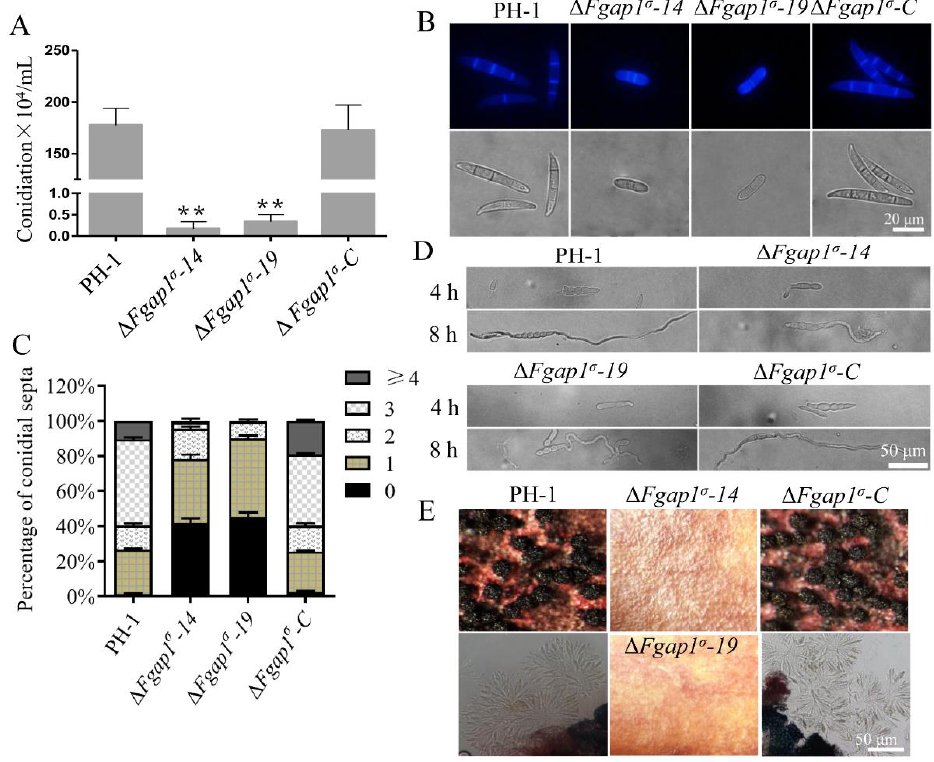
Figure 3. FgAP1 σ is involved in the conidiation and sexual development of F. graminearum . ( A ) Conidiation of the wild-type PH- 1, ΔFgap1 σ , and ΔFgap1 σ -C strains in liquid CMC media for 3 days. Level of significance was measured using an unpaired t -test (** p < 0.01). ( B ) Conidial morphology was observed under a light microscope after the PH- 1, ΔFgap1 σ , and ΔFgap1 σ -C strains were cultured in liquid CMC media for 3 days. Bar = 20 μm. ( C ) The number of septa in the conidia produced by the indicated strains. ( D ) Germination of the indicated strains in CM media after 4 h and 8 h of inoculation. Bar = 50 μm. ( E ) Images of the perithecia and ascospores produced by the PH- 1, ΔFgap1 σ , and ΔFgap1 σ - C strains after 2 weeks of inoculation on carrot agar plates. Bar = 50 μm.